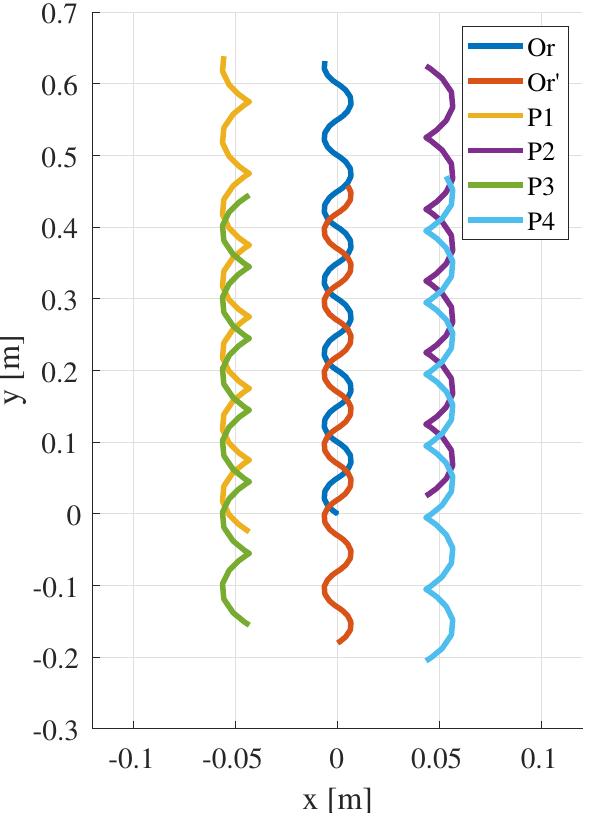
Figure 5. The trajectories of each joint in the simulation for forward locomotion. The simulation results show that the robot moves forward by setting β = 0.